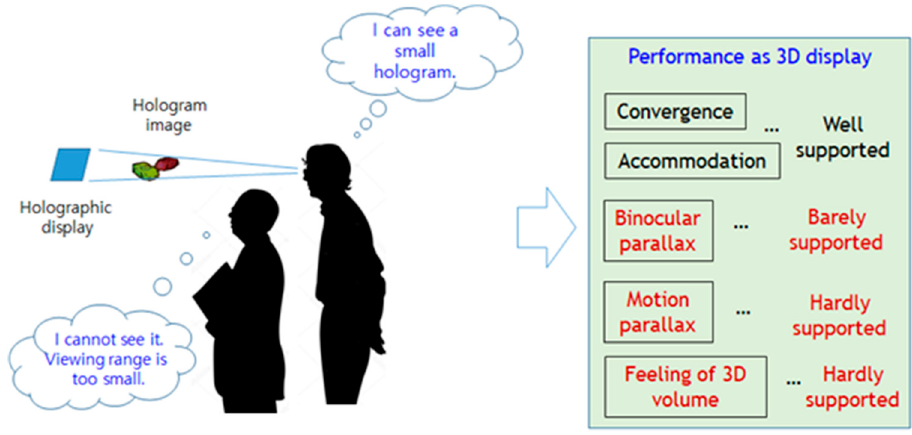
Figure 1. Current status of state-of-the-art holographic displays.